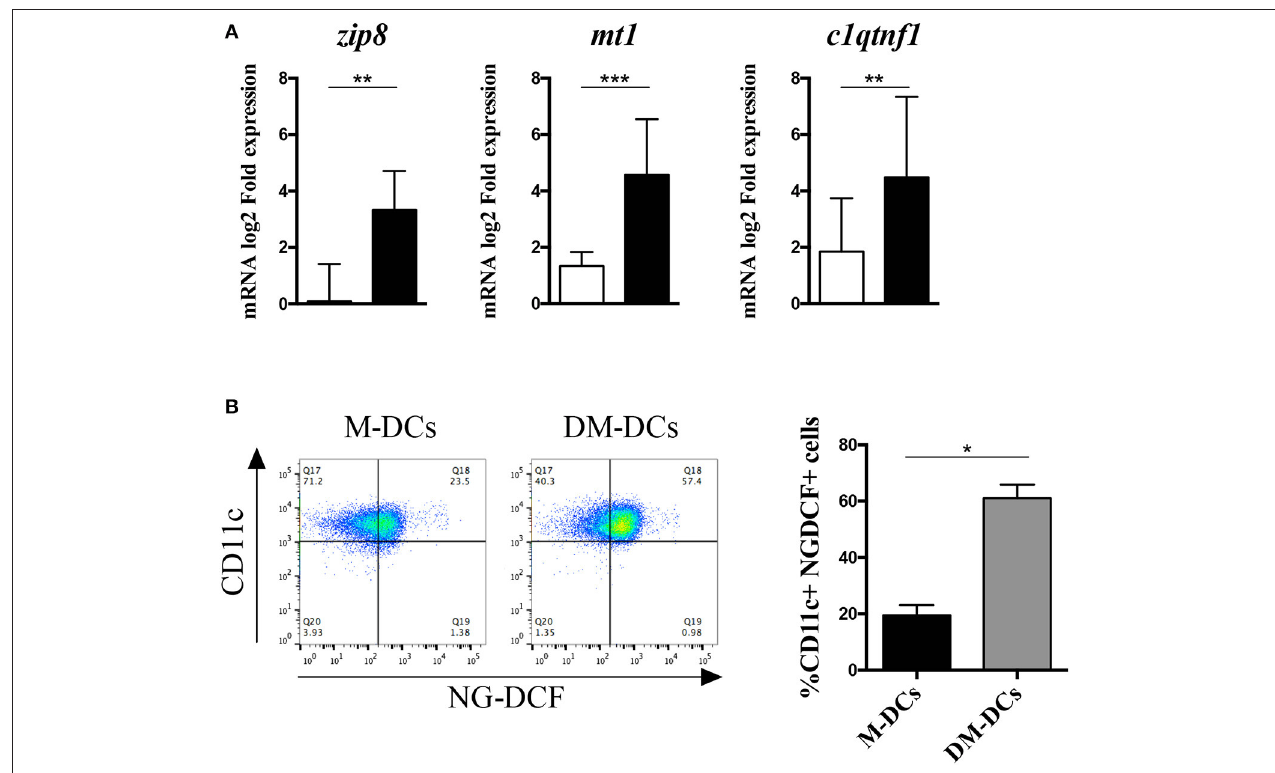
FIGURE 6 | Dex-modulated and MPLA-activated dendritic cells (DM-DCs) show high expression of zinc transporters and zinc intracellular levels. Enrichment of zinc homeostasis in DM-DCs compared to DCs and M-DCs was evaluated. (A) Gene expression of zinc binding molecules upregulated in DM-DCs microarray analysis was determined by real time PCR. Data shows fold expression values of DM-DCs and M-DCs relative to untreated DCs expression ( n = 10; * p = 0.05; ** p = 0.01; ** p = 0.001). (B) Determination of zinc intracellular levels in DCs was assessed with the zinc fluorescent indicator Newport Green DCF (NG-DCF) and analyzed by flow cytometry. Shown are percentages of CD11c + cells positive for NG-DCF intracellular staining ( n = 4; * p = 0.05, ** p = 0.01). M-DCs, MPLA-matured